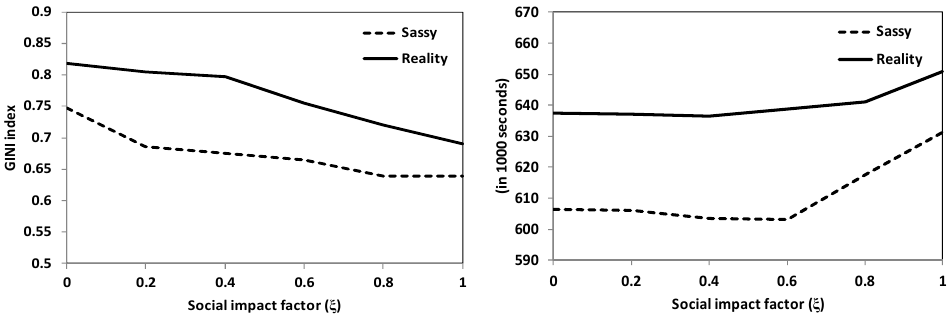
Figure 11. ( left ) Social impact factor ( ξ ) vs. GINI index, and ( right ) social impact factor ( ξ ) vs. delivery latency of Bubble-TLDA for Reality ( F th = 150 ks) and Sassy ( F th = 2 ks). A social impact factor represents the contribution of neighbours’ influence on the node popularity. A higher ξ leads to a lower GINI index, but somewhat increases the delivery delay.